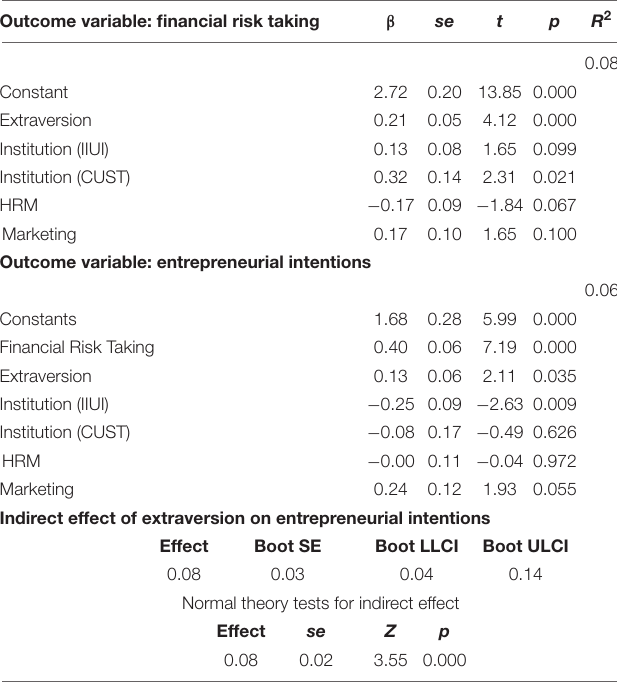
TABLE 3 | Mediating role of financial risk taking between extraversion and entrepreneurial intentions. Outcome variable: financial risk